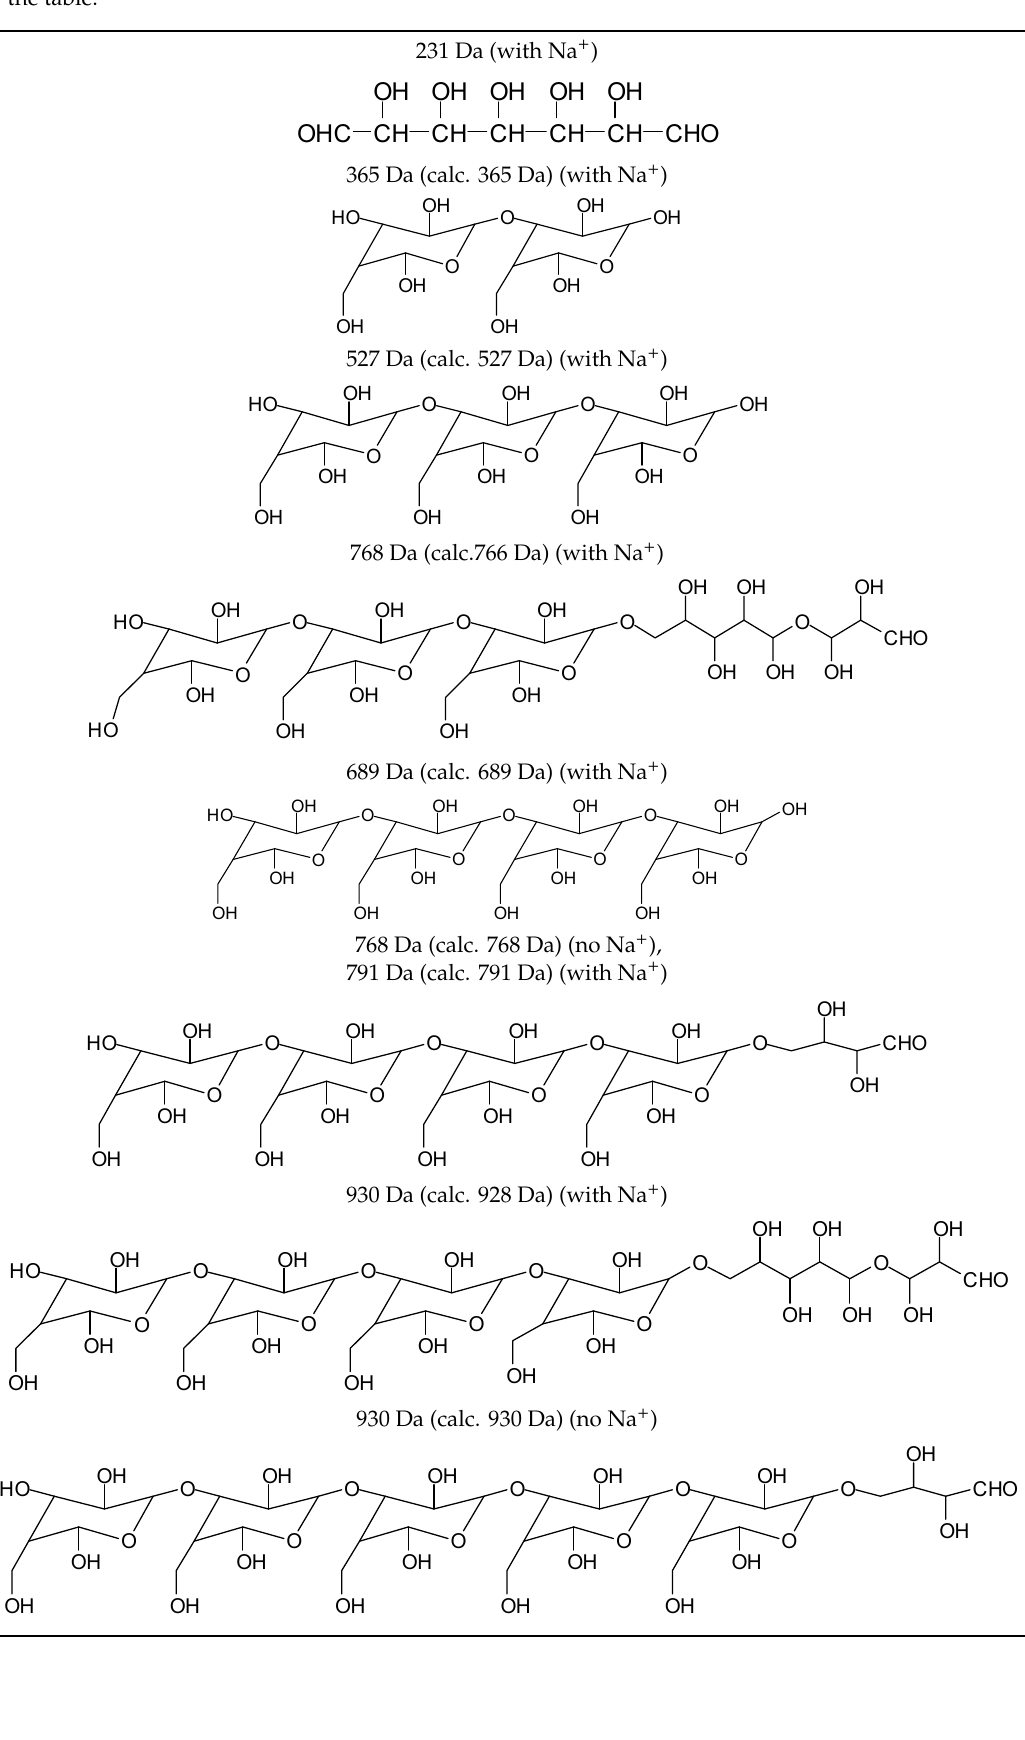
Table 1. The proposed oligomer species for the MALDI ToF spectra peaks in Figure 1a–c for the between the glucose units are alpha-glucosidic. They are represented as being beta glucosidic to shorten the